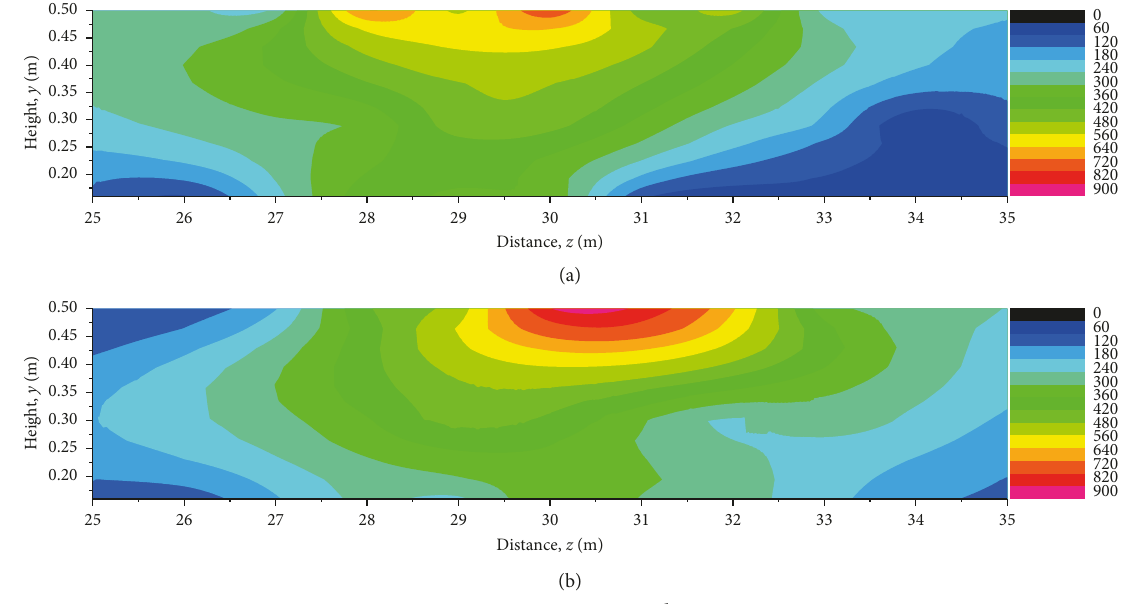
0, V 2 0. (b) V 1 (cid:31) (cid:31)